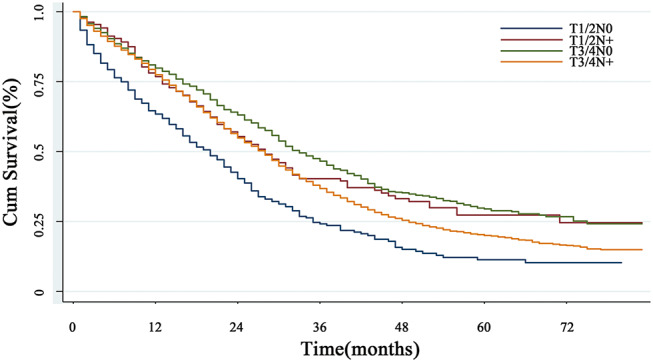
The overall survival in subgroup analysis with lymph node status. When the N status was taken into consideration, the survival curve showed that T1/2N+ subgroup had the worst prognosis, while the prognosis of T3/4N0 was the best (P < 0.001).